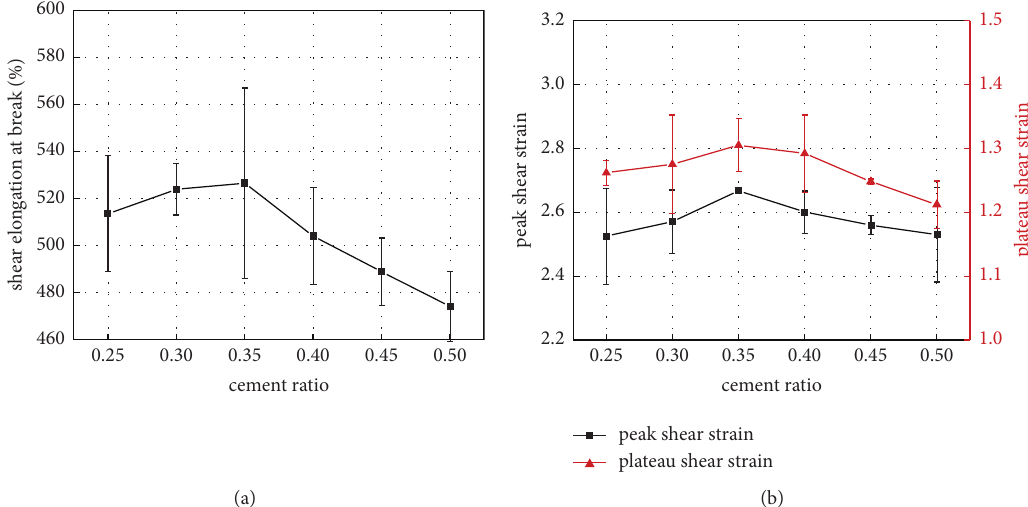
Figure 15: Changes of PCC shear deformation indexes with cement ratio: (a) shear elongation at break; (b) peak shear strain and plateau shear strain.